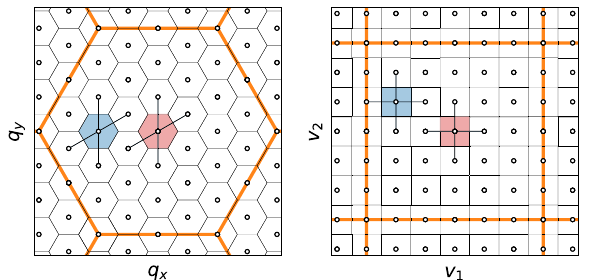
Fig. 2 Graphical representation of the 6 × 6 × 1 Monkhorst – Pack sampling of an hexagonal units cell. In the left panel, the reciprocal space is represented in cartesian coordinates ( q ), in the right panel in reciprocal lattice coordinates ( v ). A Monkhorst – Pack grid is always rectangular (or squared) in reciprocal lattice coordinates. The BZ in both representations are highlighted with thick orange lines. Smaller hexagons (squares) represent the mini-BZ of the q sampling in cartesian (reciprocal lattice) coordinates. The mini-BZ at Γ is highlighted in red, while an example at q ≠ 0 ( v ≠ 0) in blue. Black lines connect the q point with its nearest neighbours in reciprocal lattice coordinates, which are used for the